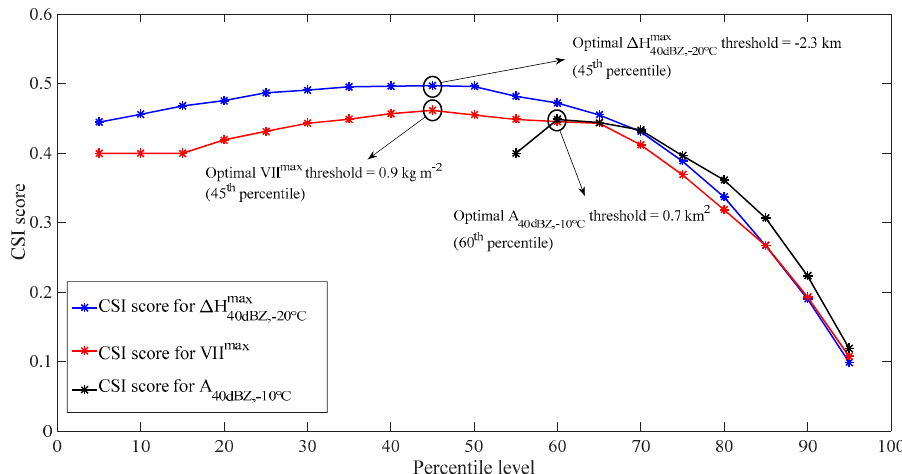
Figure 5. Behavior of Critical Success Index (CSI) score for different percentile levels of the following single-parameter criteria: ∆ H max 40dBZ, − 20 ◦ C (blue curve), VII max (red curve) and A 40dBZ, − 10 ◦ C (black curve). The three optimal thresholds ( ∆ H max 40dBZ, − 20 ◦ C = − 2.3 km, VII max = 0.9 kg m − 2 and A 40dBZ, − 10 ◦ C = 0.7 km 2 ) have been determined from training dataset.